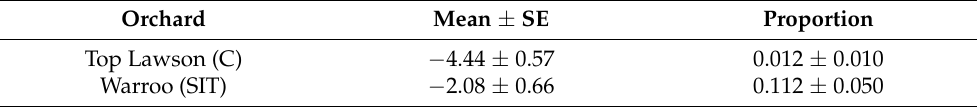
Table 3. Predicted proportion of fruit sampled with Helicoverpa spp. damage (score > 0) by fruit type and orchard, showing the mean ± SE on the logistic scale and predicted proportion ± approximate SE